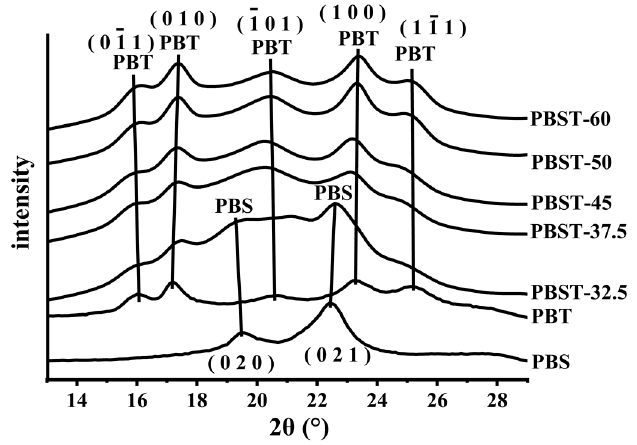
Figure 1. The diffraction profiles of neat PBT, PBS homopolymers, and PBST copolymers with the BT content. Table 2. Crystal size and crystal plane spacing of PBST copolymers with different BT contents when the diffraction peak was at 17.3°.